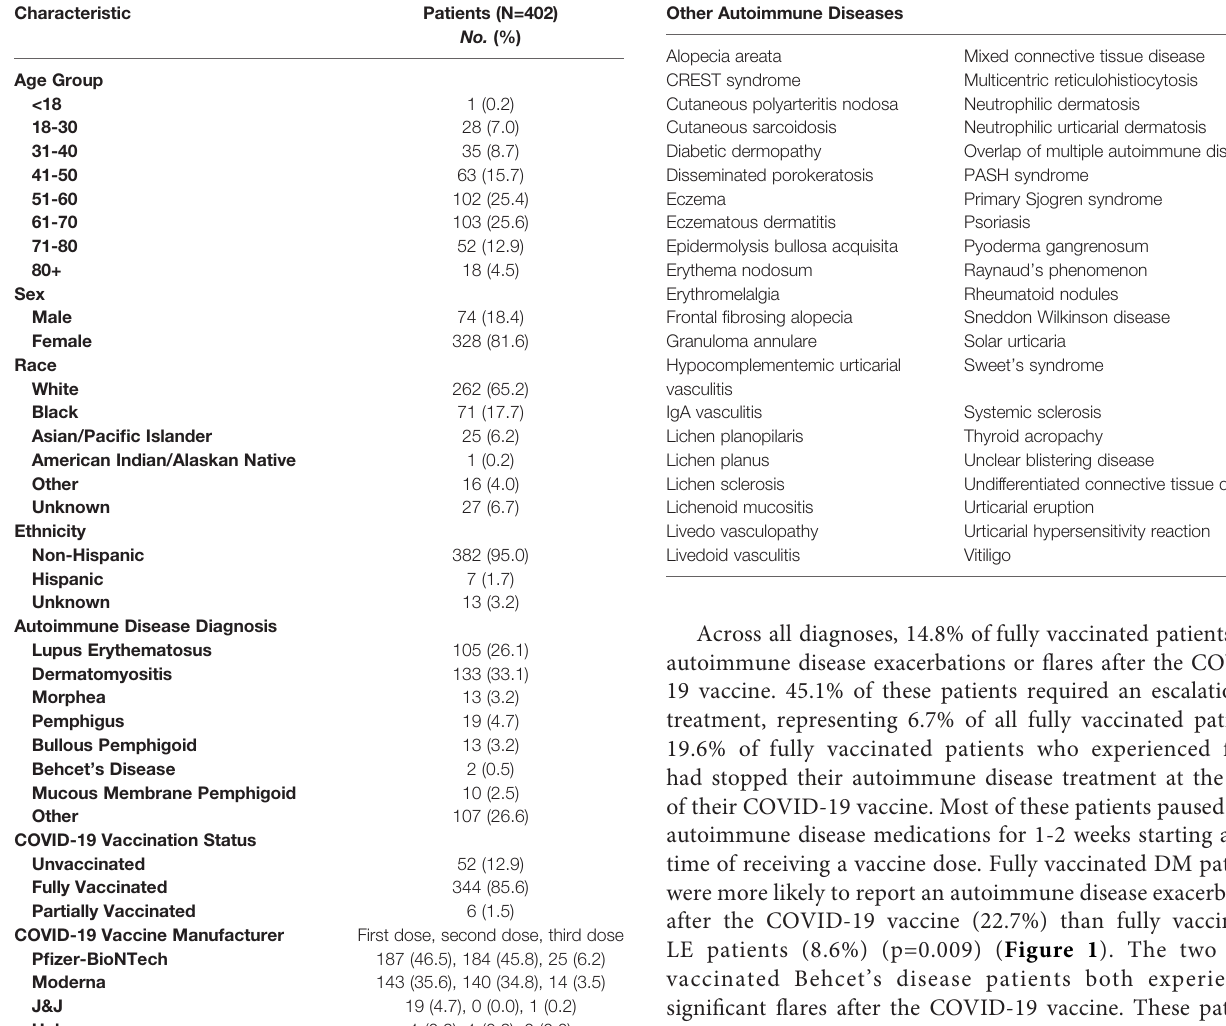
TABLE 2 | Autoimmune diseases included as “ other ” No. (%)